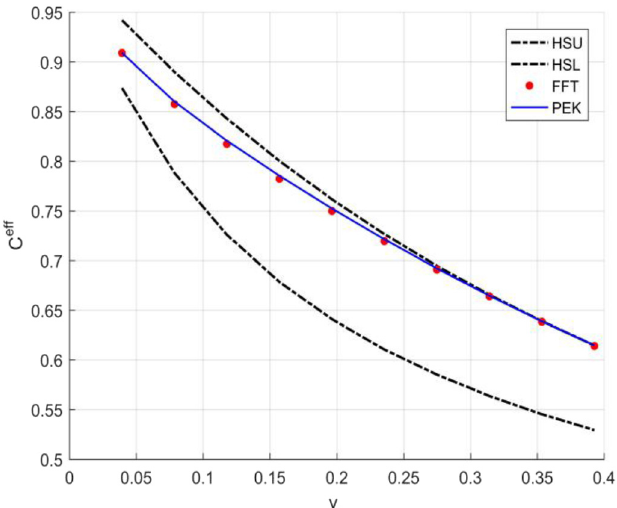
Fig. 5. Effective conductivity of square model with